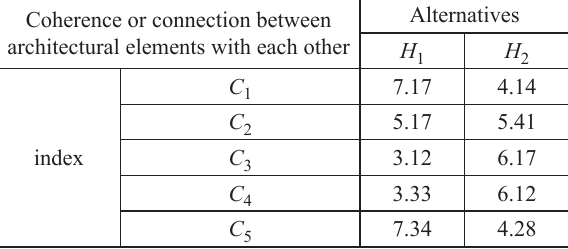
Table 16. Averages of experts’ scores assessing coherence or connection between architectural elements with each other within the major index Coherence or connection between